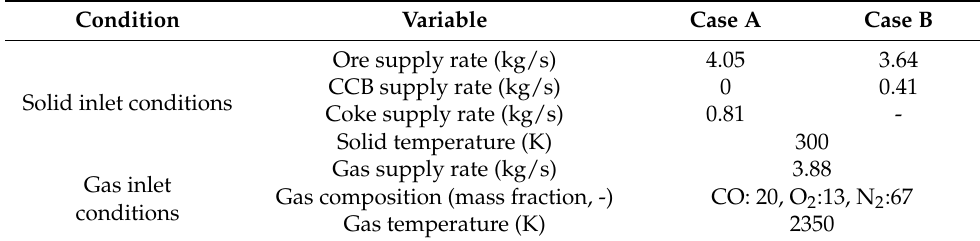
Table 7. Gas and solid inlet conditions of cases A and B (1/30 BF